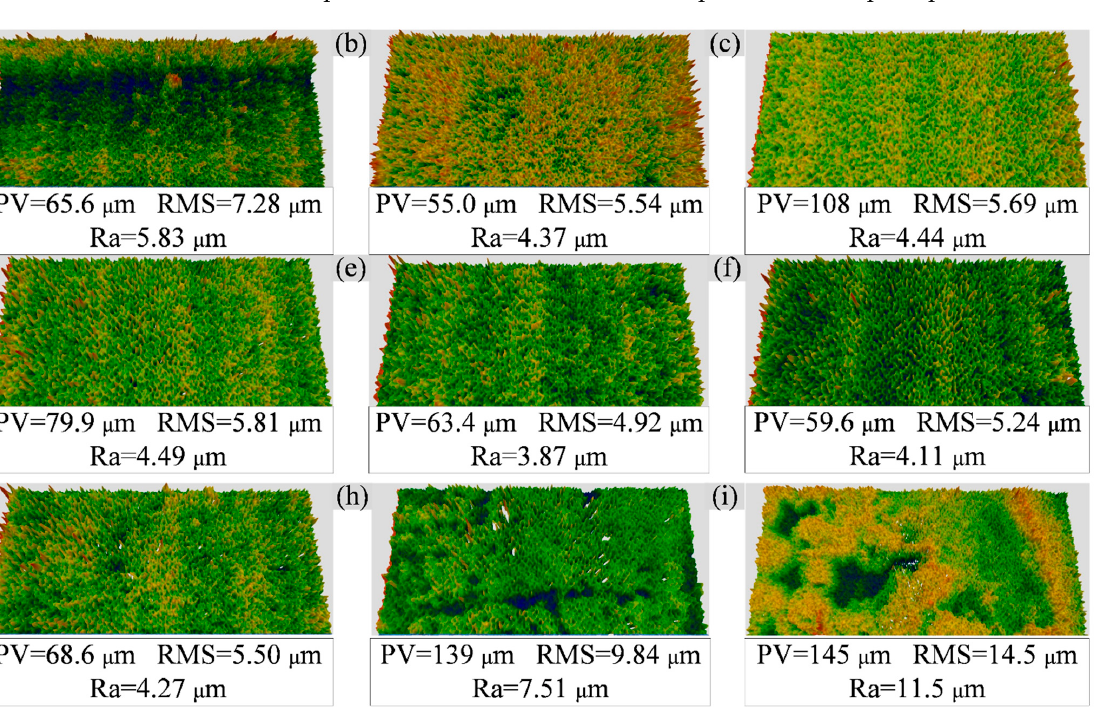
Figure 8. Surface macromorphology and roughness of aluminized specimens. ( a – i ) are specimens #1–9 in order. #1–9 in